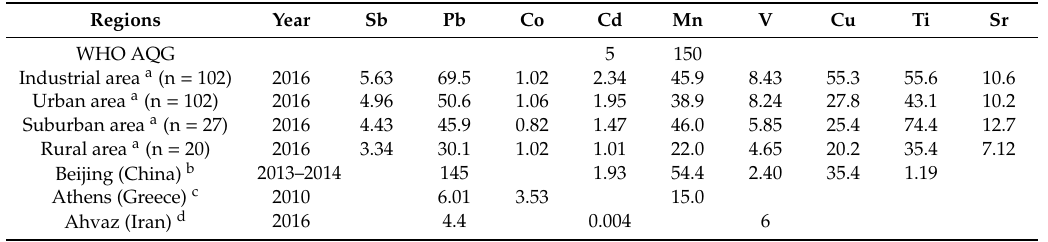
Table 2. Atmospheric concentrations (ng/m 3 ) of heavy metals in PM 2.5 from industrial, urban, suburban, and rural areas of Nanjing, China compared with other regions.